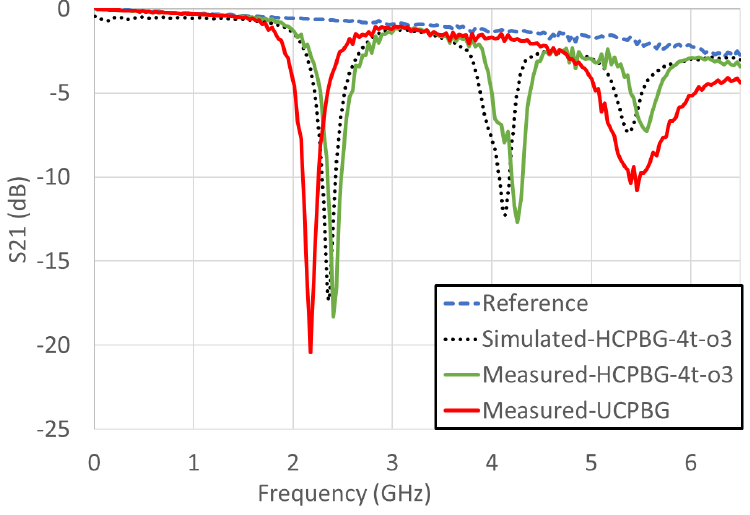
Figure 9. Measurement—transmission loss for HCPBG with 4 traces, orientation 3 vs.